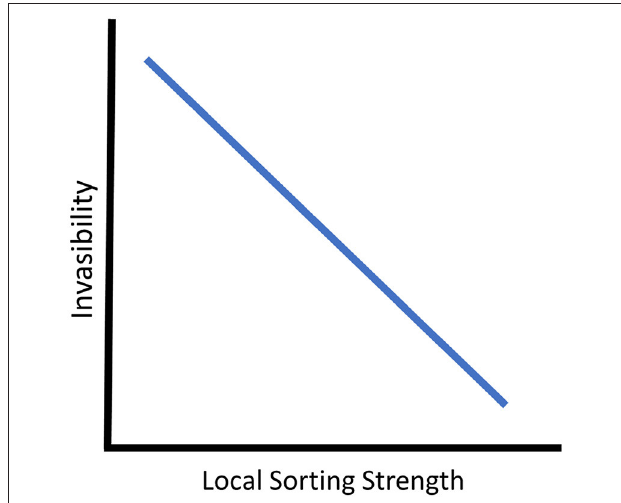
FIGURE 5 | Hypothesized relationship between local sorting strength and invasibility of a local